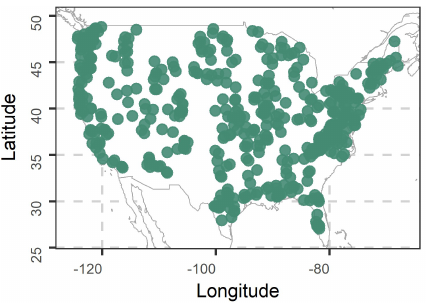
Figure 1. Locations of the 513 catchments examined in the fore- casting